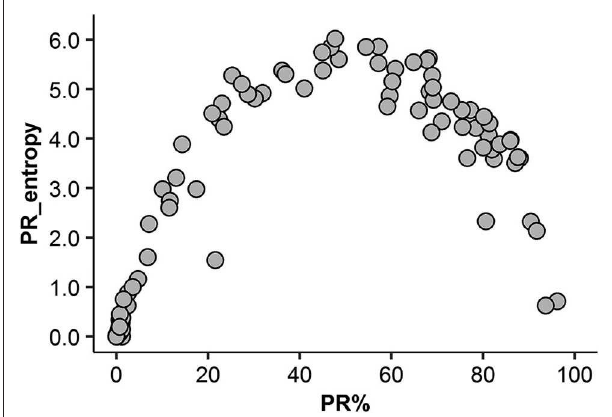
FIGURE 4 | Non-linear association between the rate of PR expression and its intratumoral heterogeneity (entropy).